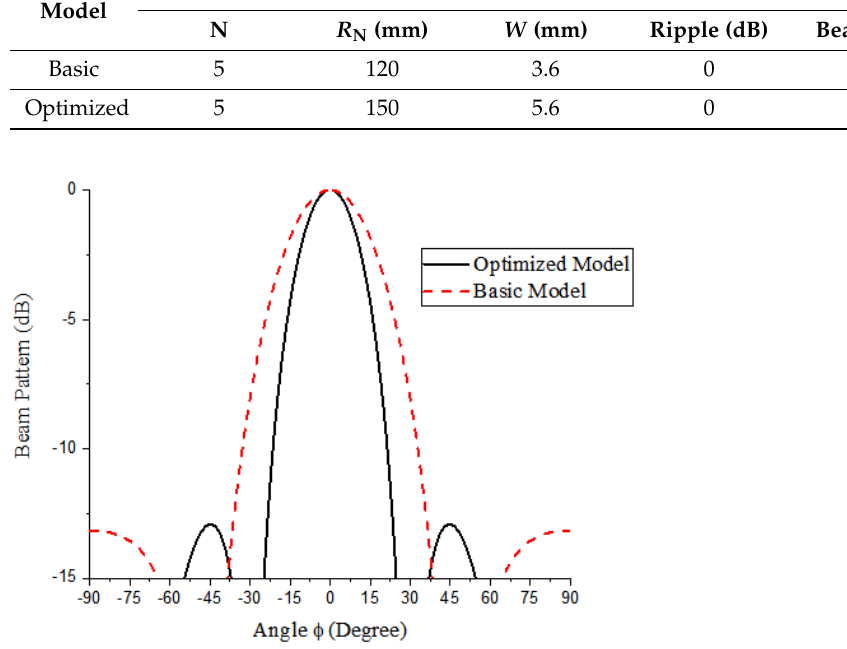
Figure 6. The beam pattern of the N-subarray part of the optimized conformal structure compared with the basic model.